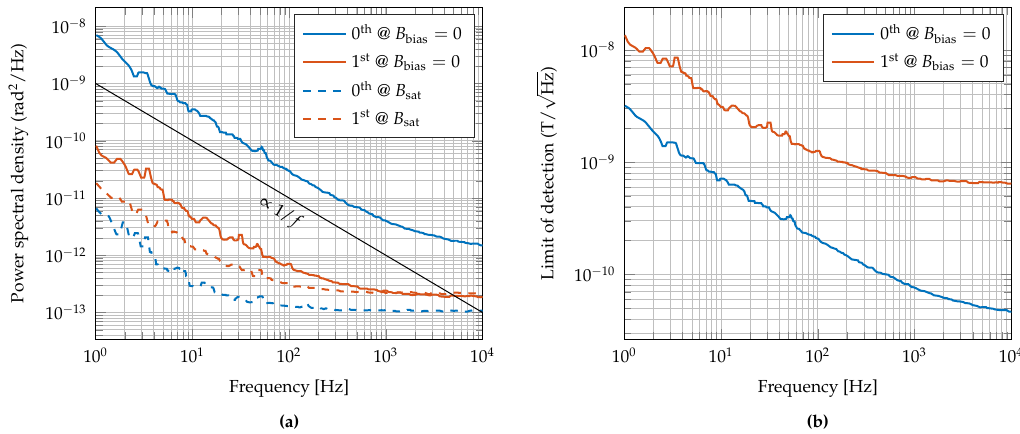
Figure A2. ( a ) Measured power spectral densities of random phase fluctuations in the magnetic operating point (continuous lines) and in magnetic saturation (dashed line) of the sensor with p = 12µm for fundamental and first-order mode. ( b ) Calculated limit of detection for both